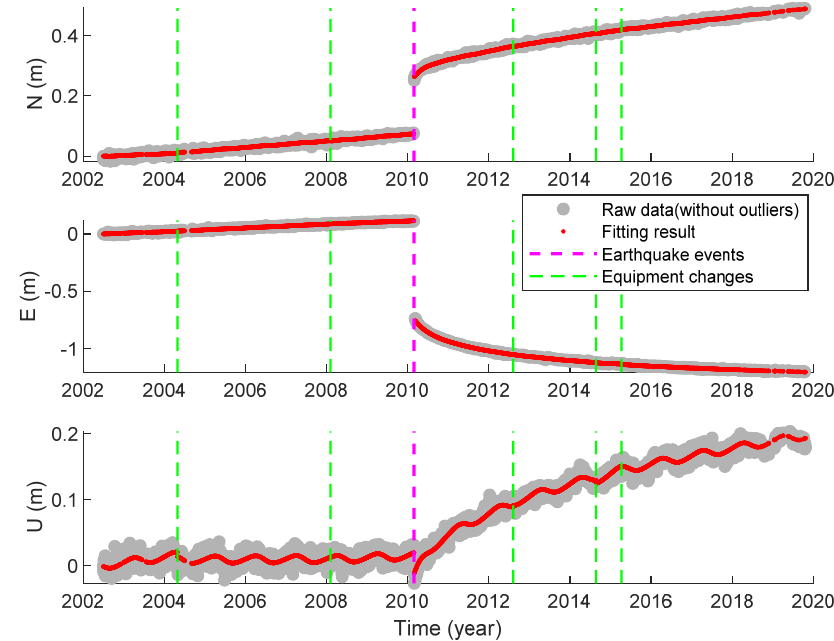
Figure 12. Fitting results of ANTC’s time series using ITSM. It can be seen from Figure 12 that modeling the offset, velocity, PSD, and seasonal variation (annual and semi-annual) in GNSS time series, and the ITSM model can almost perfectly describe the trajectory of the site in each direction. Table 4 shows the specific parameter result of ANTC’s time series using the ITSM. Table 4. Parameter fitting result of ANTC’s time series using ITSM. Velocity Earthquake CSD PSD Semi-annual